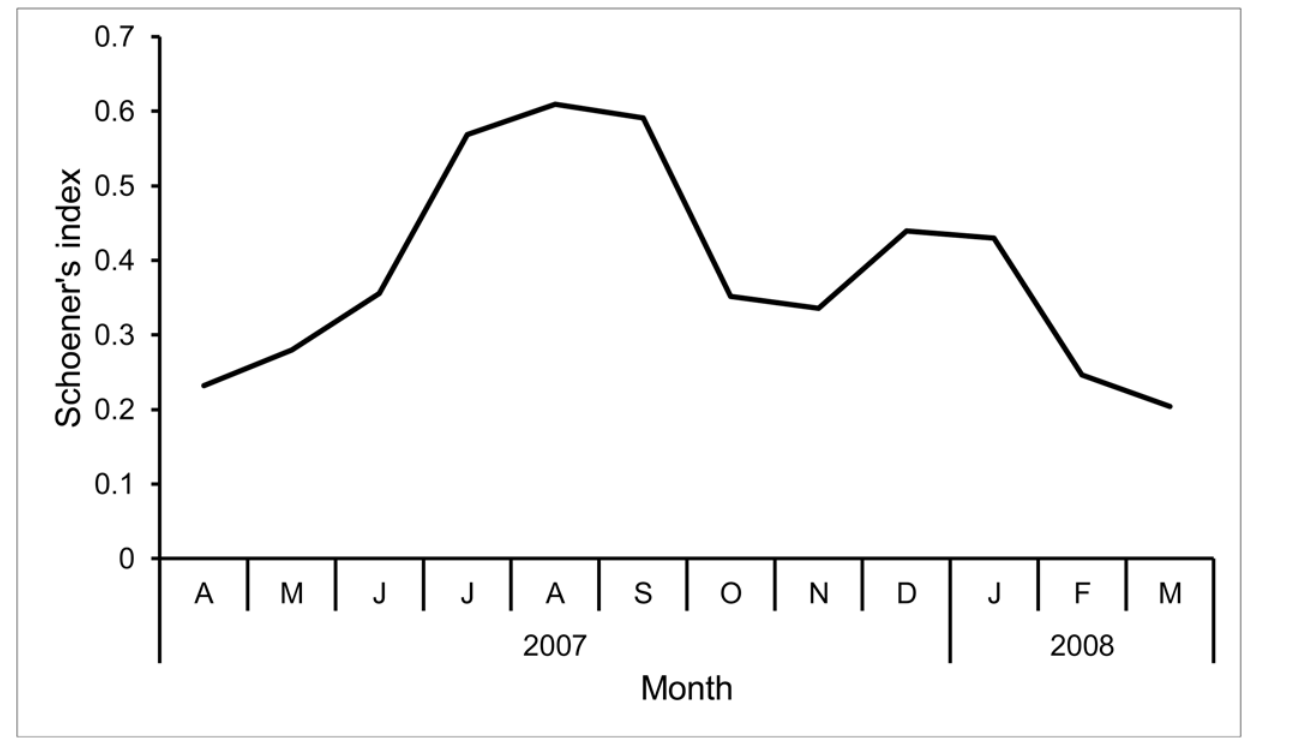
Fig 5. Overlap of the macaque groups ’ diets. Monthly variation of Schoener ’ s indices.